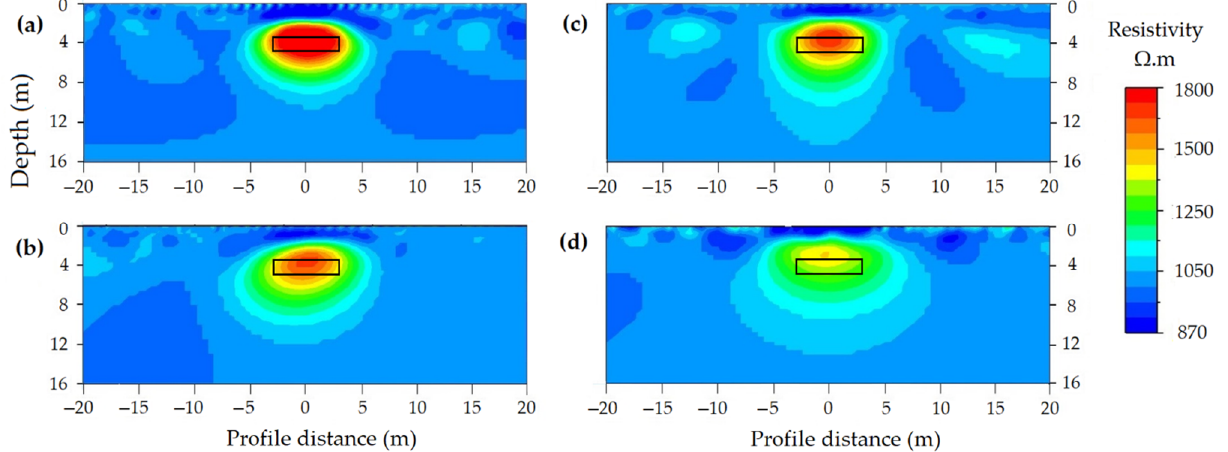
Figure 14. The inverted resistivity model for scenario 2 with 1.5 × 6 m cavity size using: ( a ) DD array, ( b ) PD array, ( c ) WS array, ( d ) PP array. The rectangular box indicates the actual cavity target.